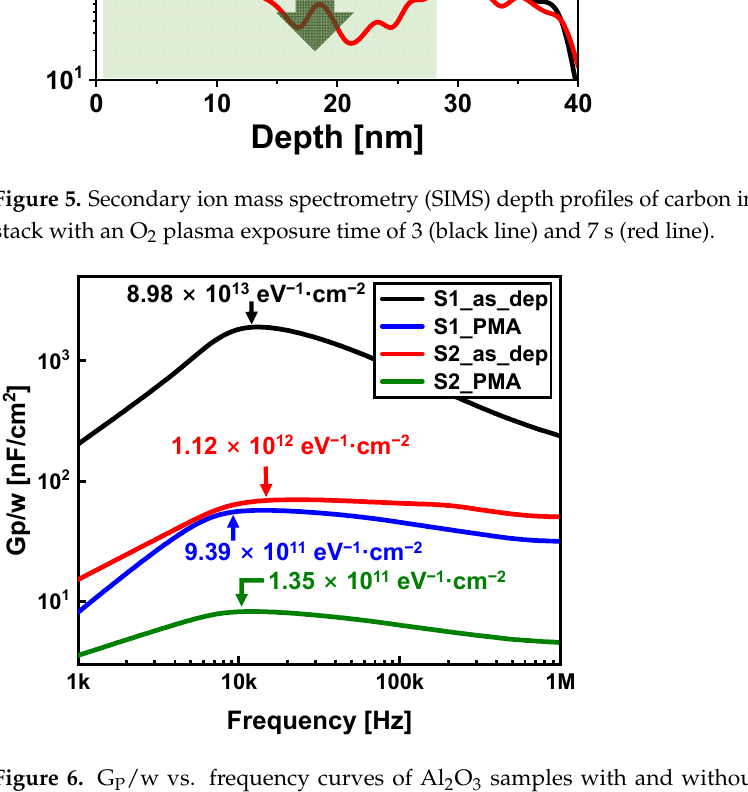
( b ) Figure 7. ( a ) Leakage current vs. gate electric field of Al 2 O 3 samples with and without PMA. ( b ) Fowler–Nordheim (FN) plots of I–V curves for as-deposited Al 2 O 3 samples with an O 2 plasma ex- posure time of 3 (black triangles) and 7 s (red triangles).